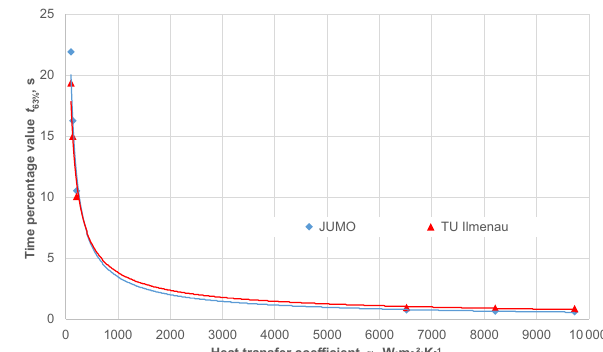
Figure 9. Dependence of the time percentage value t 63% on the heat transfer coefficient α